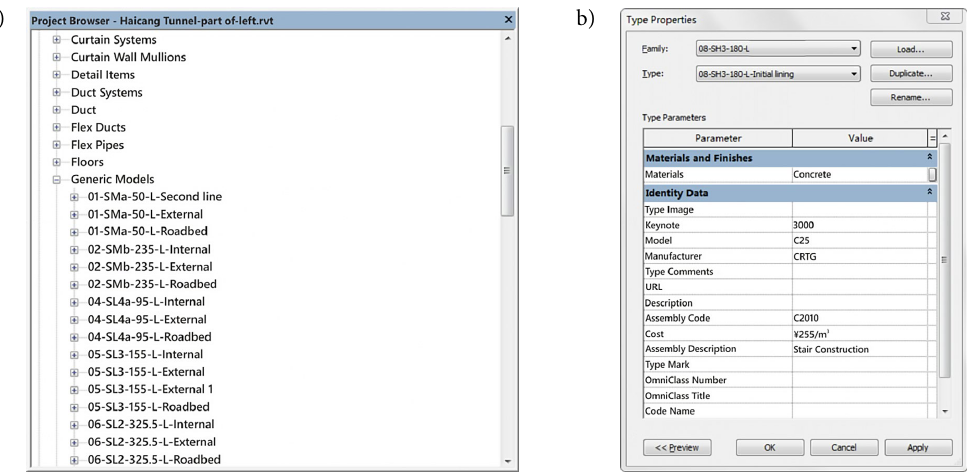
Figure 5. a – The naming pattern and classification of components shown in the Revit